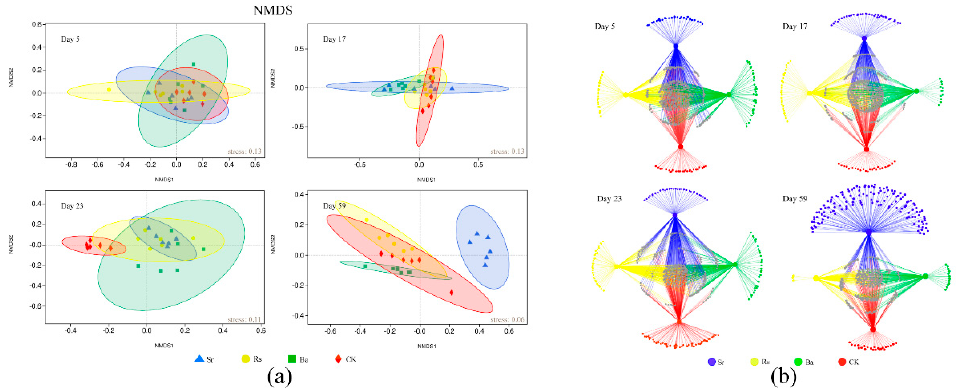
Figure 4. ( a ) Non-metric multidimensional scaling (NMDS) analysis of bacterial community structure under four treatments during four plant growth stages. Ellipses in the plots denote 95% confidence intervals for the centroids of different treatments. NMDS analysis is shown along two primary dimension-reduced axes. Axes were determined by non-metric multidimensional scaling and are presented in Bray-Curtis dissimilarity units. Colors indicate the treatment; ( b ) Bipartite association network, the large nodes represent different treatment groups, the small nodes represent unique OTUs belong to each treatment, the color represents the OTUs shown in the legend and the small gray nodes represent the common OTUs.